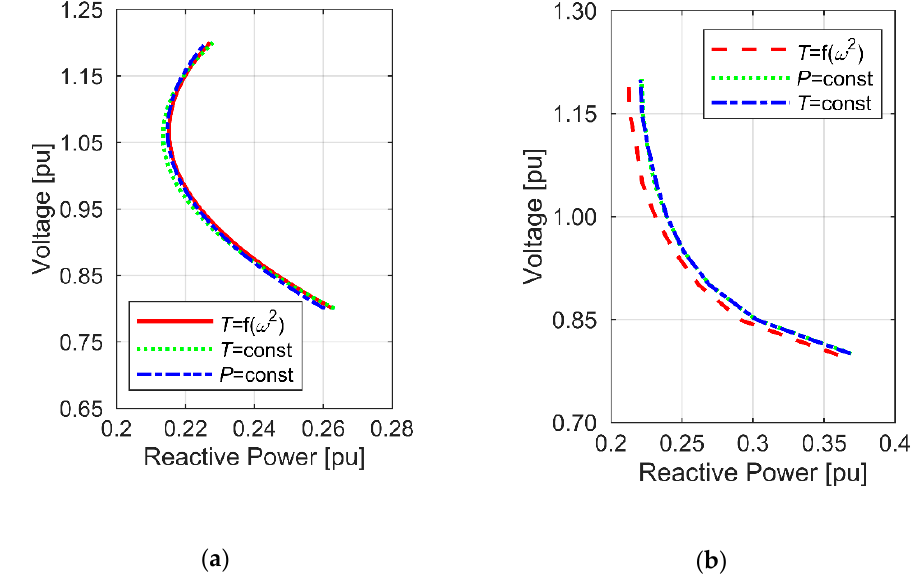
Figure 4. Characteristics of a drive-controlled (elaborated base on [26,27]): ( a ) closed-loop operated three-phase motor for nominal speed; ( b ) closed-loop operated single-phase motor.